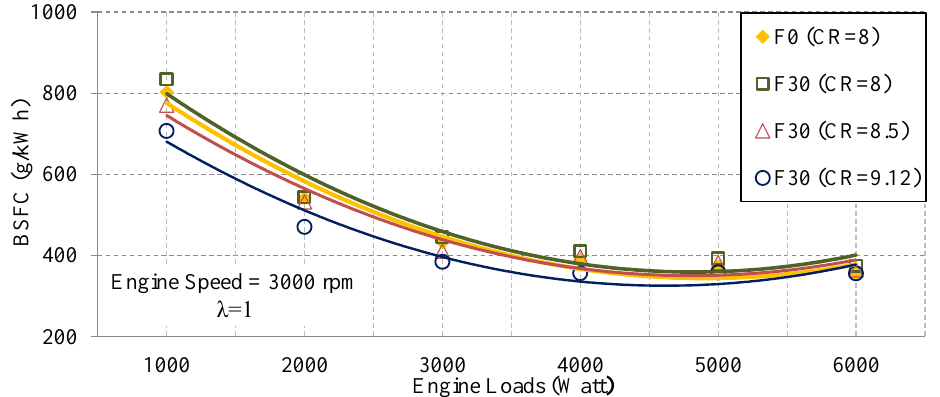
Figure 9. Specific fuel consumption for F0 and the F30 blend at different compression ratios.